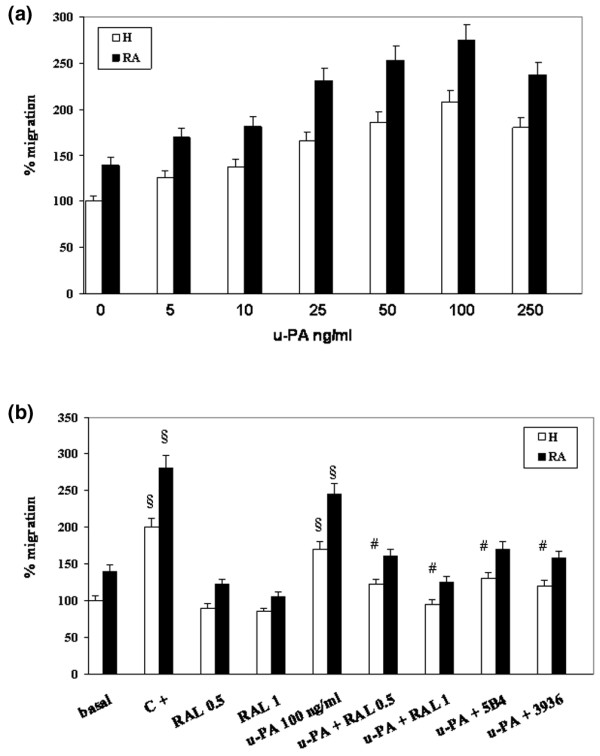
Urokinase-type plasminogen activator (u-PA)/u-PA receptor (u-PAR)-dependent chemoinvasion in healthy (H) and rheumatoid arthritis (RA) synoviocytes. (a) Cell invasion of Matrigel-coated filters by H and RA synoviocytes as a function of u-PA concentration. Migration was stimulated by increasing concentrations of u-PA (5 to 250 ng/ml) in the lower well of the migration chamber. (b) Percent increase of Matrigel invasion in H and RA synoviocytes treated with Raloxifene (RAL) or neutralizing antibodies. Basal, invasion of H and RA synovial cells in the presence of 0.2% FCS in the lower well; C+, invasion stimulated by conditioned medium of A431 cell line, used as a sure chemotactic agent; RAL 0.5 and RAL 1, invasion challenged with 0.5 μM and 1 μM RAL in the lower well; u-PA, invasion challenged with 100 ng/ml of u-PA in the lower well; u-PA+RAL 0.5 and u-PA+RAL 1, invasion challenged with 100 ng/ml u-PA in the presence of 0.5 and 1 μM RAL in the lower well; u-PA+5B4 and u-PA+3936, invasion challenged with 100 ng/ml u-PA in the presence of 1.5 μg/ml of monoclonal antibodies 5B4 and 3936 in the lower and upper well, respectively. In (a) and (b), each point represents the mean ± standard deviation of three experiments performed in triplicate on four normal and four RA synovial cell lines. § = p < 0.01 versus basal (0.2% FCS); # = p < 0.001 versus u-PA, for both H and RA.